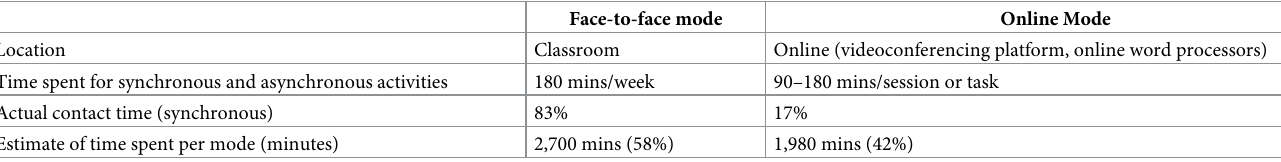
Table 2. Blended learning